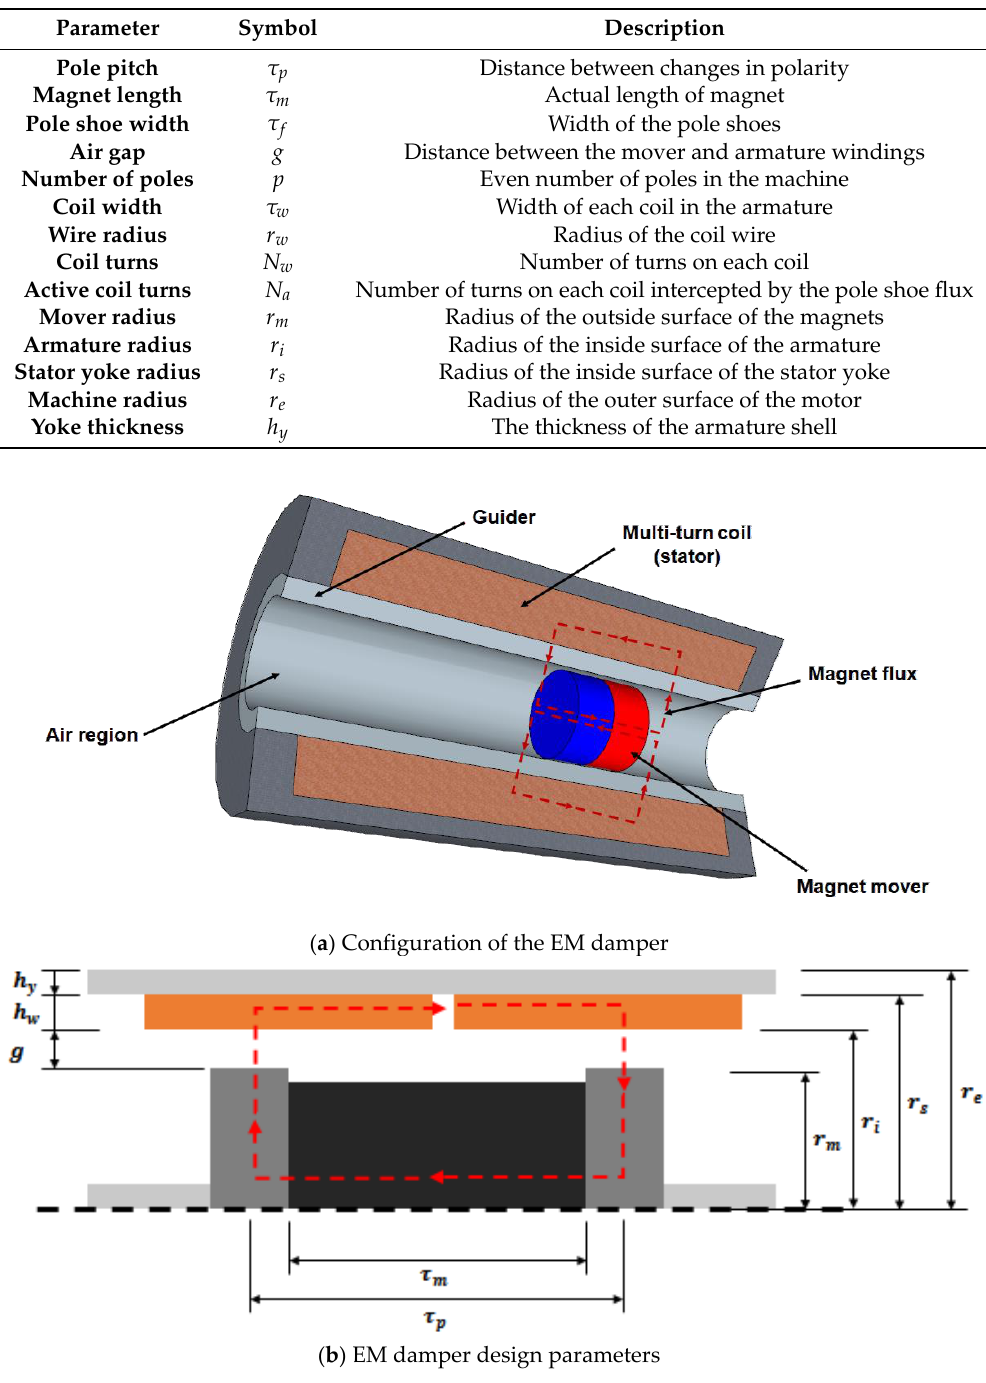
Table 1. Electromagnetic (EM) damper design parameter [12].